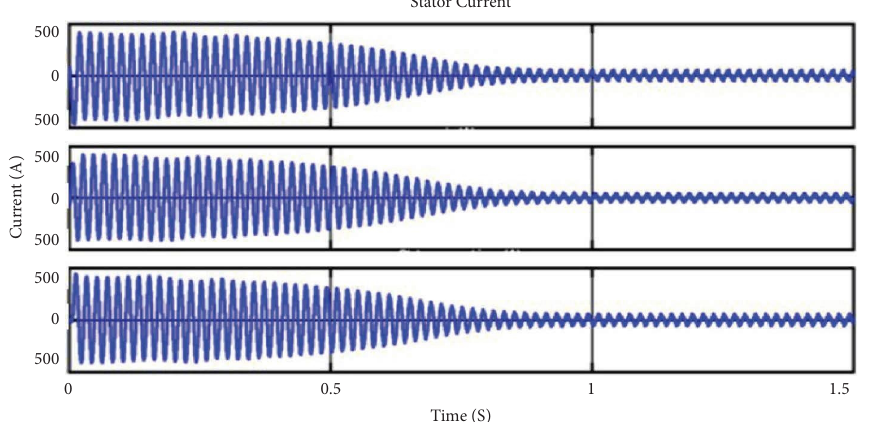
Figure 9: Tree-phase stator